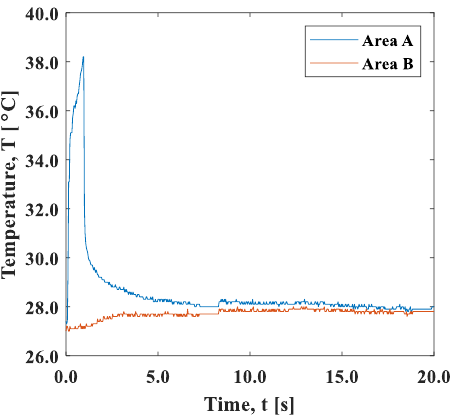
Figure 5. Time variation of temperature of areas A and B shown in Figure 3.